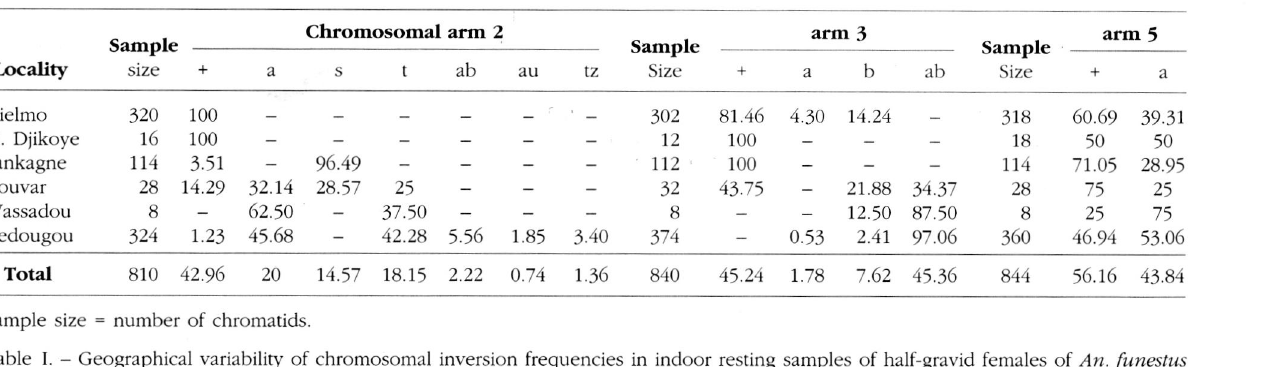
Table I. - Geographical variability of chromosomal inversion frequencies in indoor resting samples of half-gravid females of An. funestus from various localities in Senegal.